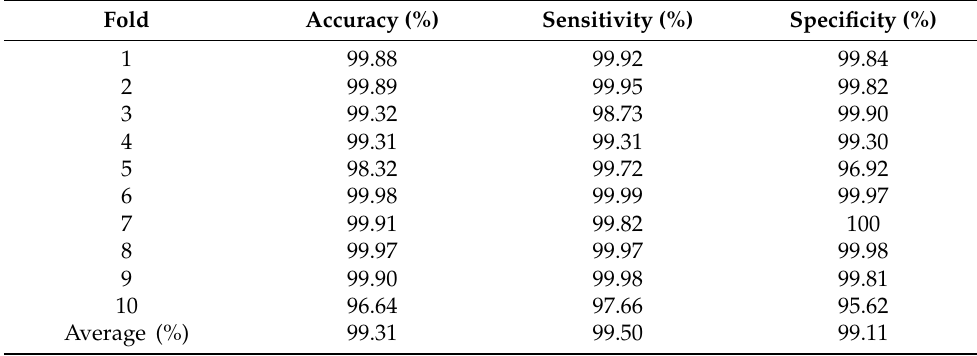
Table 3. Ten-fold evaluation metrics of the CNN model (Balanced dataset).